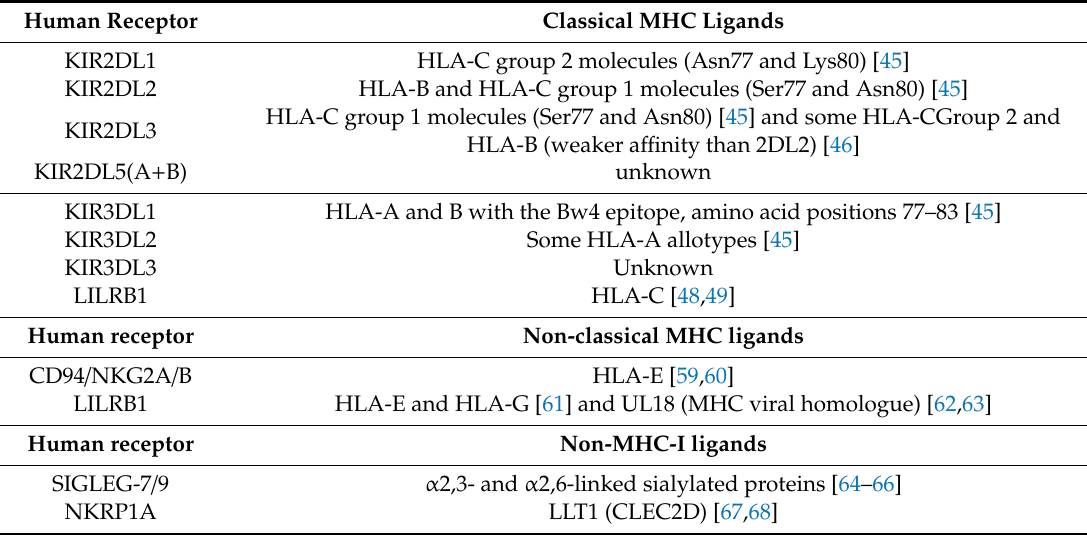
Table 2. NK cell inhibitory receptors and their ligands